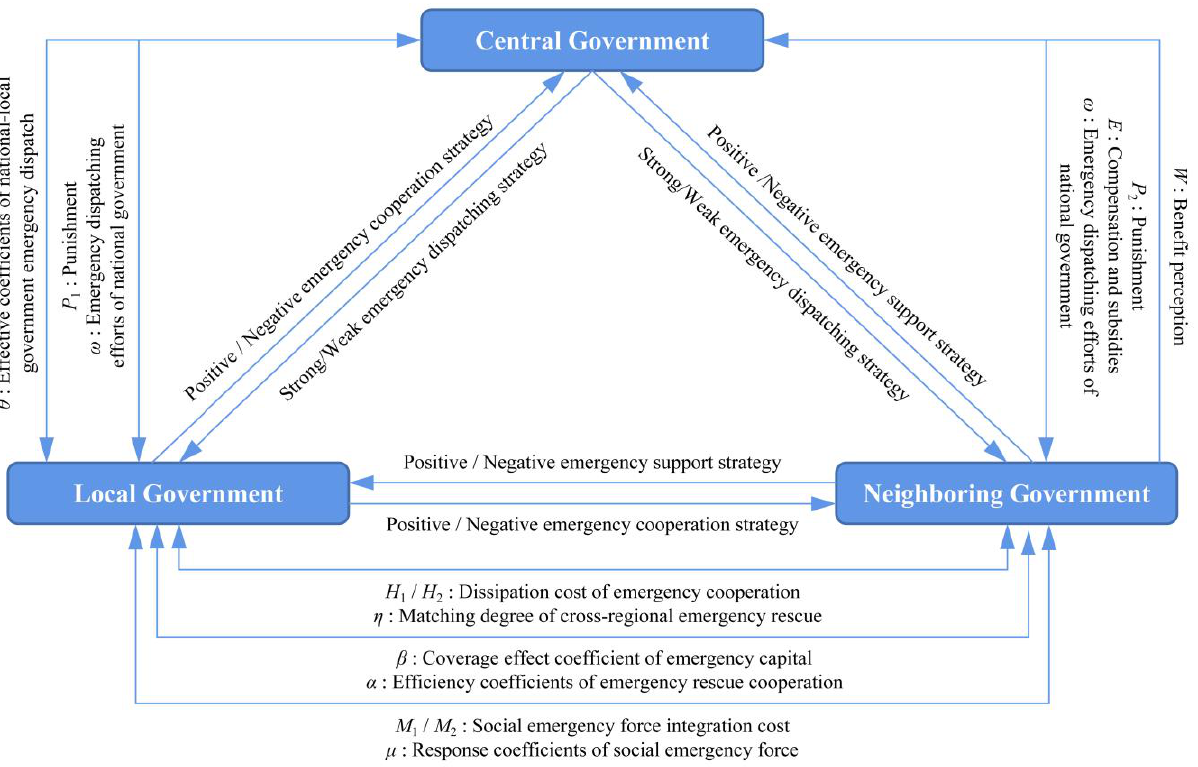
Figure 1. The game relationship between local, neighboring, and central governments. Table 1. Definition of parameters.